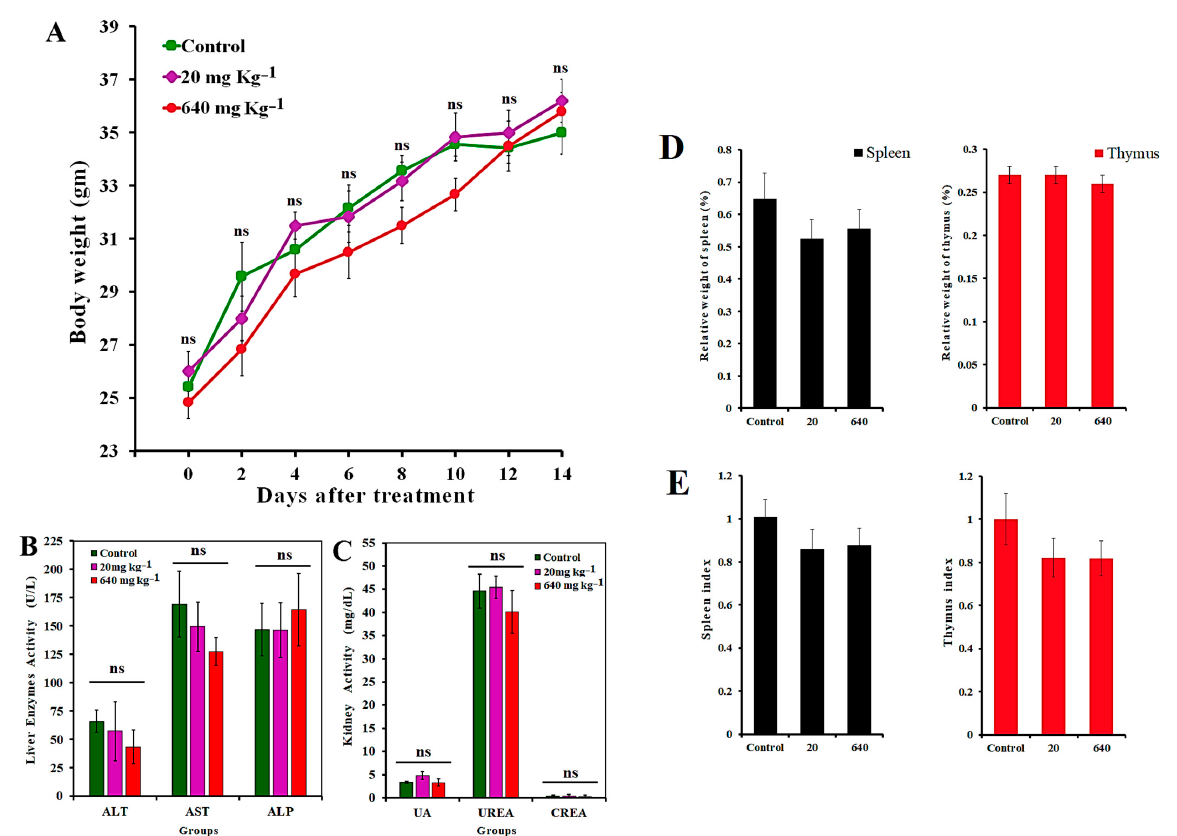
Figure 12. ( A ) Effect of GAL/ β -CD on mice body weight. No significant difference was detected in both dosage 20 mg kg − 1 and 640 mg kg − 1 . Each value represents mean ± SEM. ( B , C ) Serum levels of liver and kidney function parameters in mice treated with GAL/ β -CD. Liver enzymes: ALT, alanine transaminase; ALP, alkaline phosphatase; AST, aspartate transaminase. Kidney function parameters: uric acid. Urea kidney function parameters: creatinine. Data are expressed as mean ± SEM. ns, non-significant. ( D , E ) The relative weight and indices of spleen and thymus after oral administration with GAL/ β -CD for 14 days by different doses (20 mg kg − 1 , 640 mg kg − 1 ).